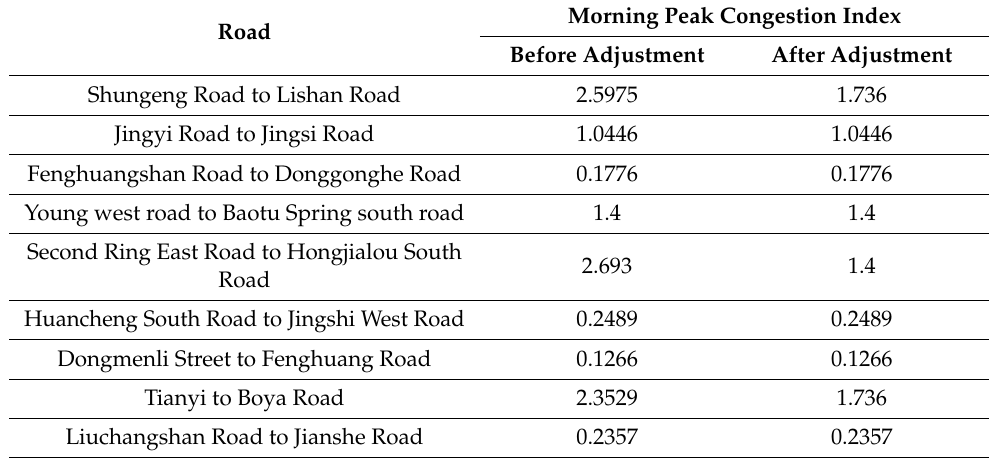
Table 8. Road congestion index before and after